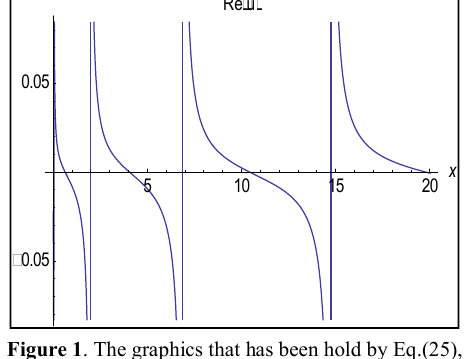
Figure 1 . The graphics that has been hold by Eq.(25), ( , ) u x t corresponding to the